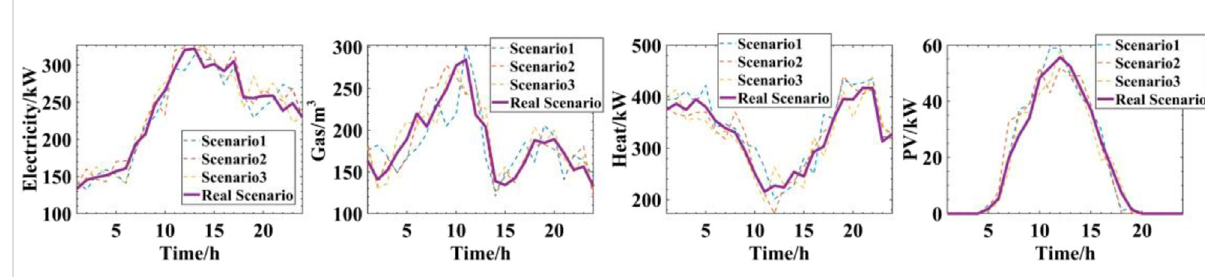
FIGURE 6 Comparisons of the scenarios generated by GAN in the day-ahead stage with the actual scenarios.